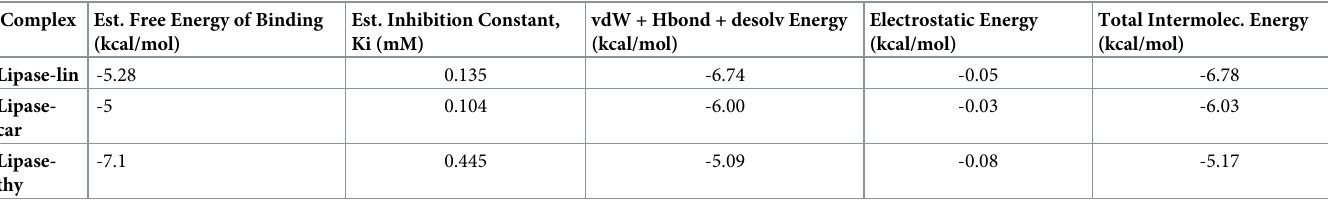
Est. Inhibition Constant, Ki (mM)